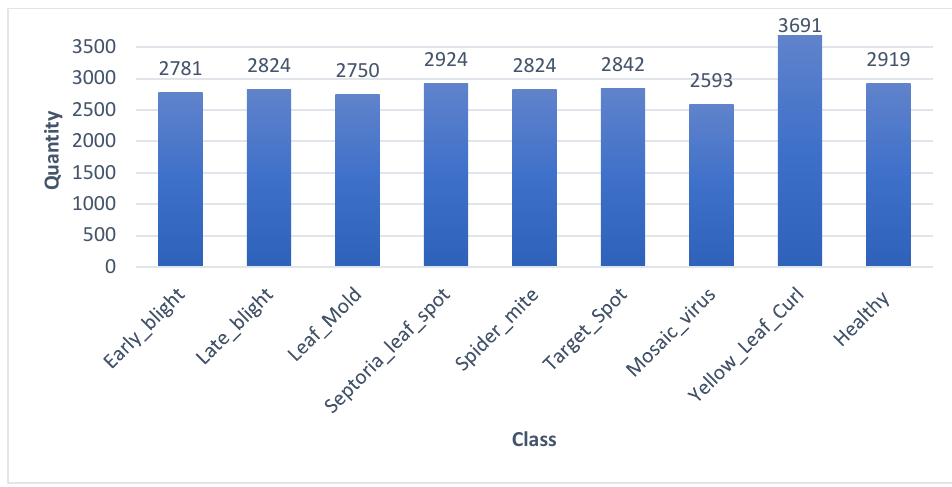
Figure 9. Number of resulting images after class balancing.